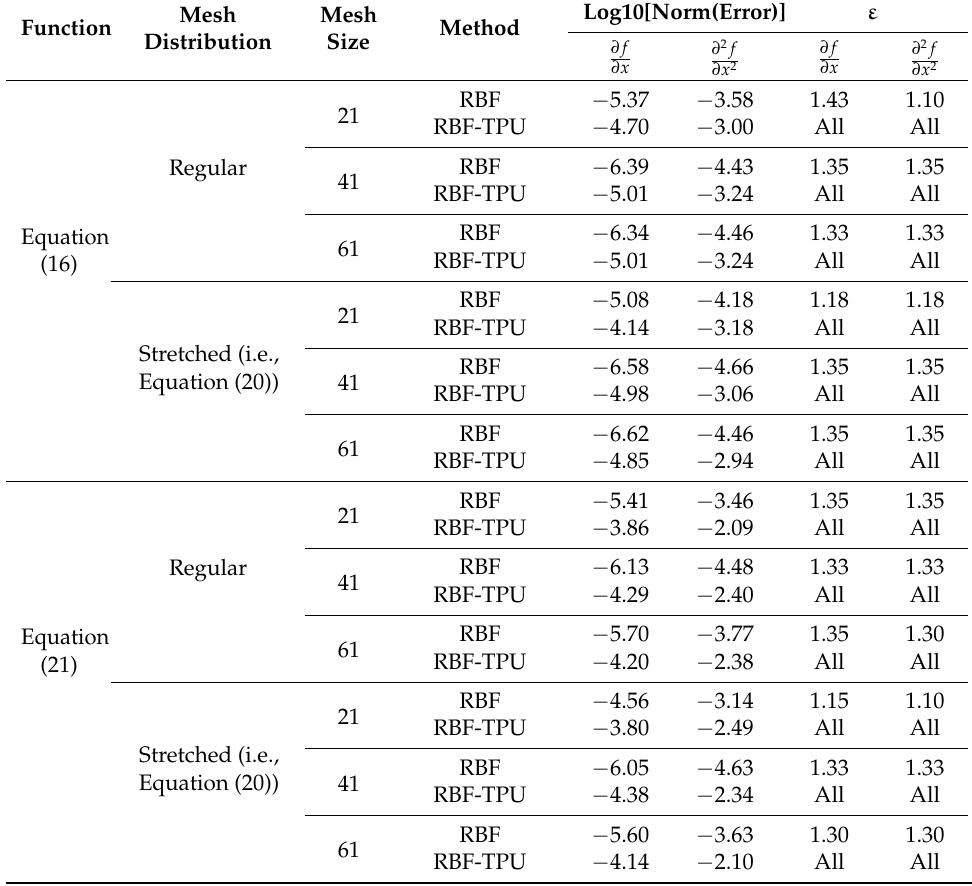
Table 2. Comparison of the minimum error for approximating derivatives between Gaussian RBF and RBF-TPU. The results of RBF-TPU are obtained from Figure 8. Note that “All” indicates the error is the same for all studied ε